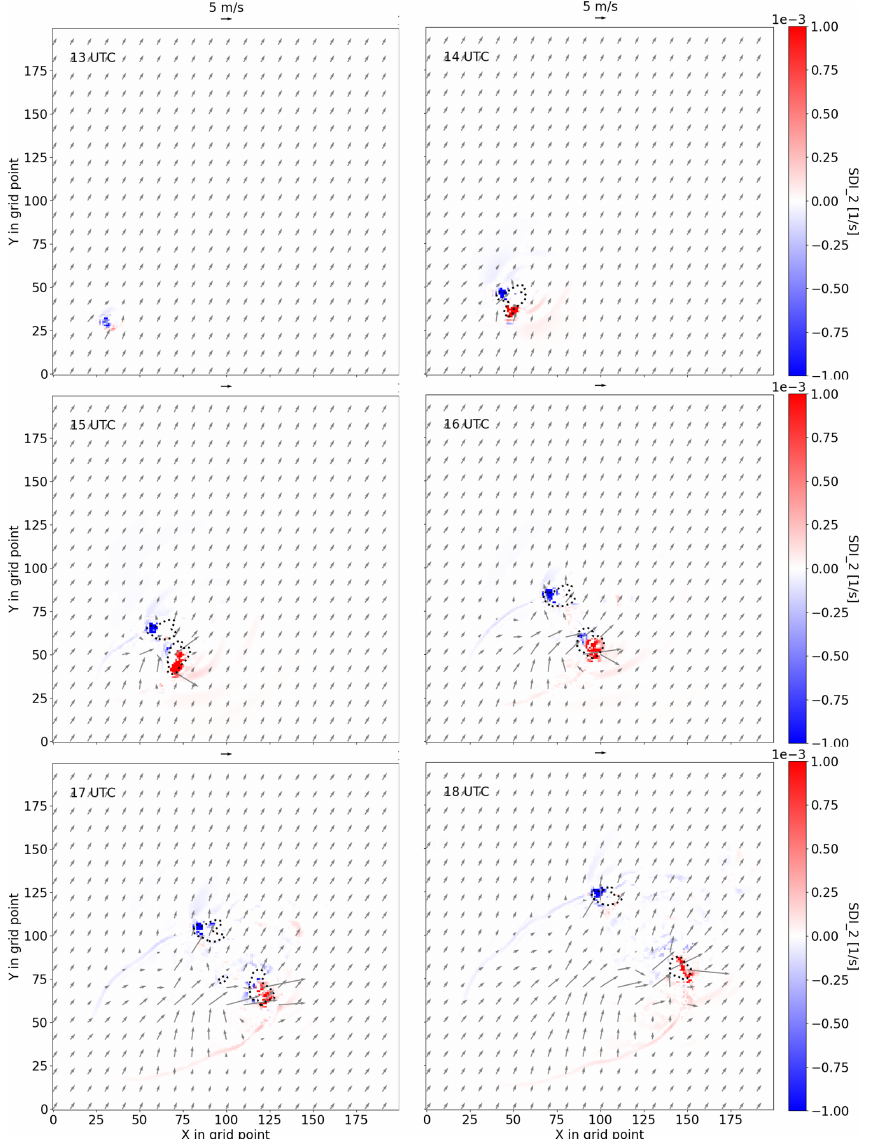
Figure 2. Nature run: development of the supercell from 13:00 to 18:00UTC, described by the horizontal wind (vectors; ms − 1 ) at the height of 1km, the radar reflectivity composite of 0 . 5 ◦ (dotted contour lines for 30dBZ) and the SDI 2 (1/s; color shading).